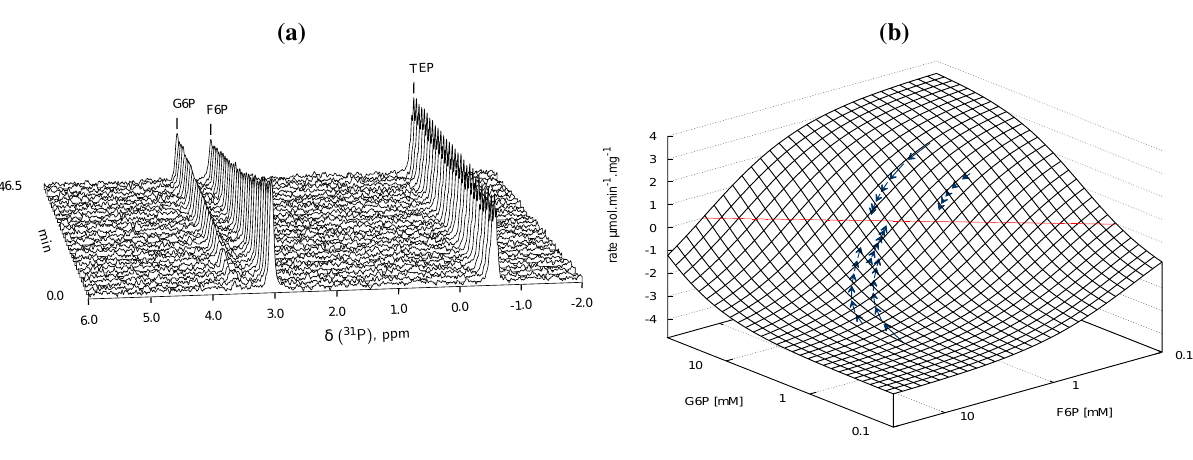
Figure 4. Phosphoglucose Isomerase. (a) Example of a 31 P-NMR time course of a PGI reaction using a cell extract incubated with an initial concentration of 8.5 mM F6P and no G6P, collected at a 60 ◦ pulse angle over 47 min (0.8 s acquisition, 0.5 s relaxation). Additional NMR parameters are described in Section 3.3. In this reaction, F6P was converted in reverse to G6P as the reaction approached equilibrium. The time course is not shown to full equilibration; final concentrations were 5 and 2.8 mM for G6P and F6P respectively. TEP is an internal standard; (b) Reversible Michaelis–Menten equation (see Table 1) fitted to PGI progress curves derived from NMR data: equilibrium values are represented by the red contour line (—), arrows indicate both the metabolite concentrations and the direction of reaction as each time course progresses towards equilibrium ( →→→ ). The rate was normalised to total protein concentration. Substrate and product concentration axes are in logarithmic scale. R 2 = 0 . 99.